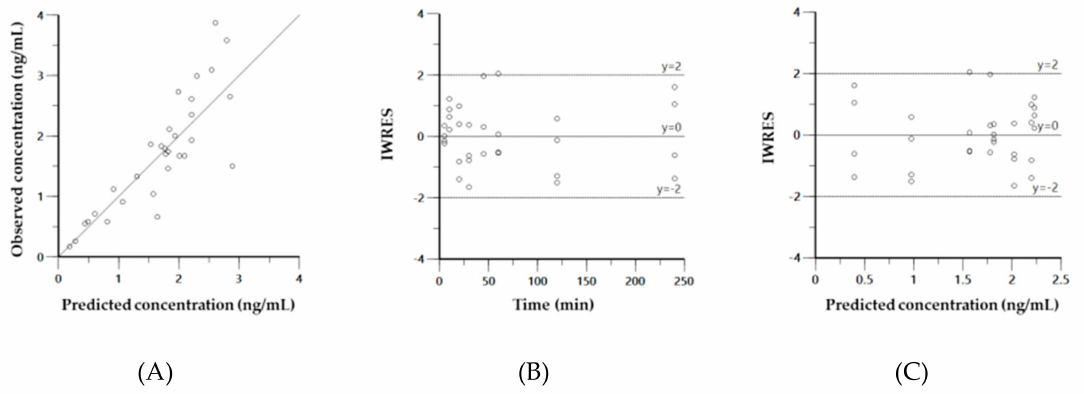
Figure 7. Diagnostic plots for the final PK model of CK41016 after eye drop administration in rabbits. Observed versus model-predicted concentration ( A ), individual weighted residual (IWRES) versus time ( B ), or model-predicted concentration ( C